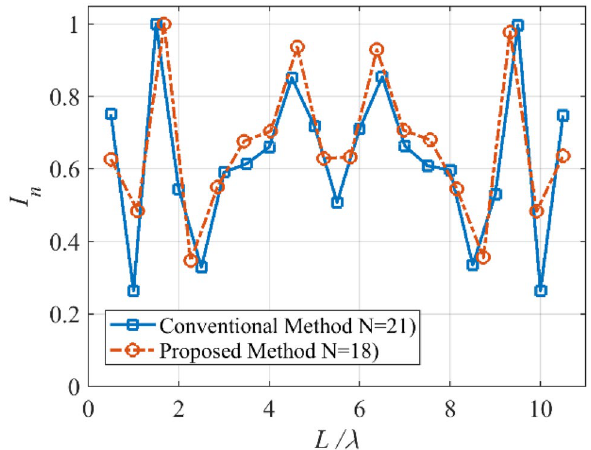
Figure 13. The obtained I n ’s of the fourth case.